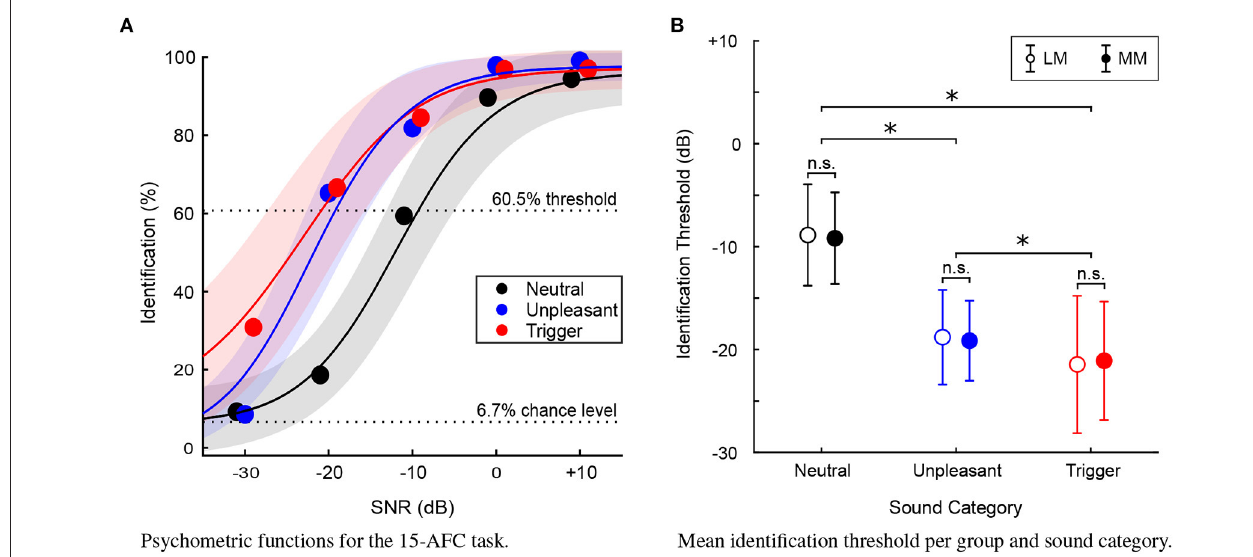
FIGURE 3 | (A) Psychometric functions ( N = 300) for the 15-AFC identification task. Average percent identification plotted at each (SNR) level, for each sound category. Solid lines represent the mean of the fits and shaded areas represent ± 1 standard deviation. Dotted lines represent chance level and the performance level chosen to define identification thresholds of the 15-AFC task. (B) Mean identification threshold for each sound category, for the Least-Misophonic (LM) and Most-Misophonic (MM) groups. Error bars represent ± 1 standard deviation. Asterisk (*) indicates a statistically significant difference ( p < 0.01), “n.s.” indicates a non-significant